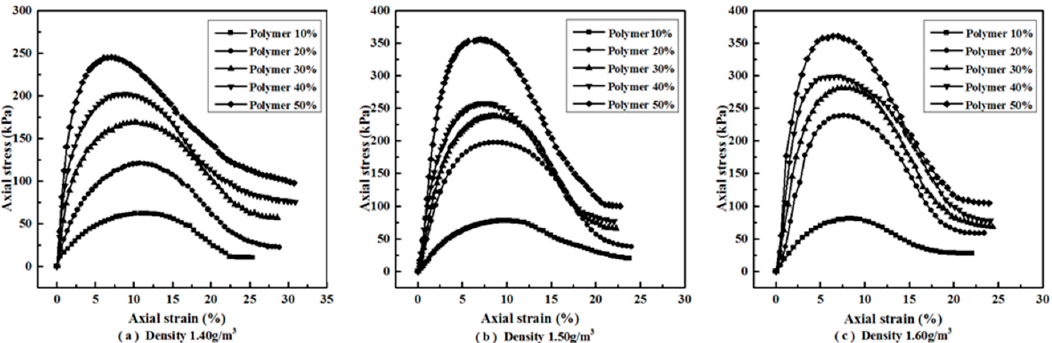
Figure 6. The axial stress–strain curves of reinforced specimens: ( a ) Density 1.40 g/cm 3 ; ( b ) Density